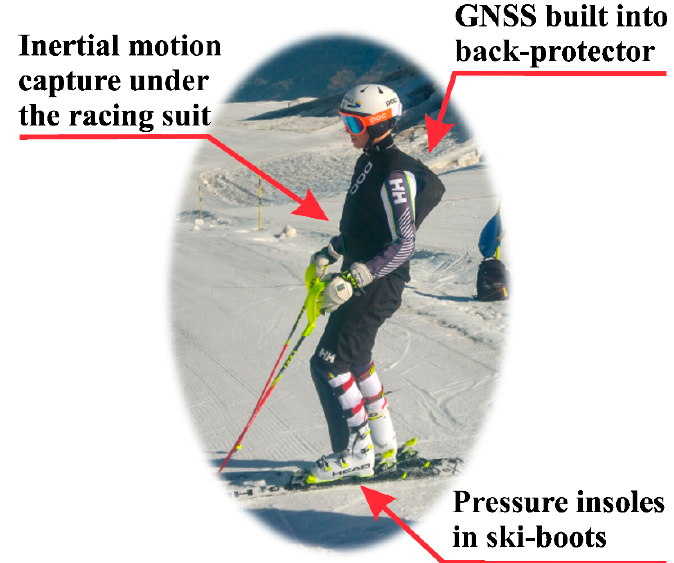
Figure 2. Equipment of the slalom skier with the global navigation satellite and inertial motion capture systems and pressure insoles.